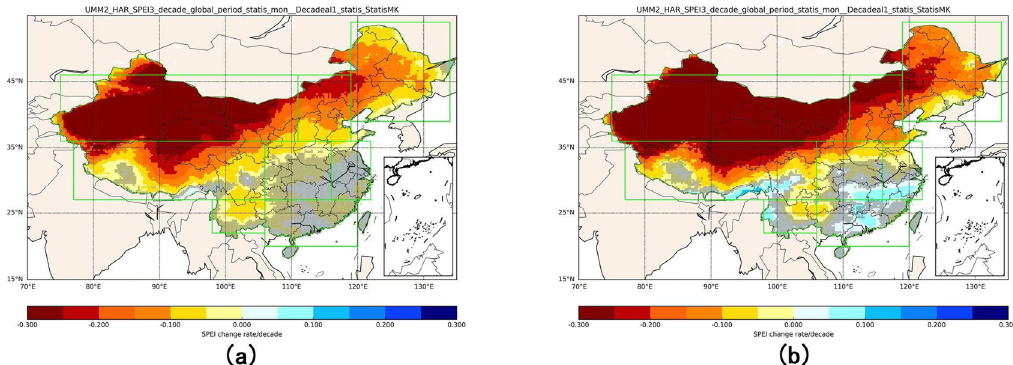
Figure 4. Spatial distribution of projected Sen’s slope estimates for decadal SPEI_3 during the period 1950–2100 under scenarios RCP4.5 ( a ) and RCP8.5 ( b ) by using MME. The value in each pixel equals the slope of { SPEI 1950–1960 , SPEI 1960–1970 , ... , SPEI 2000–2100 }. The cross-hatches represent that no